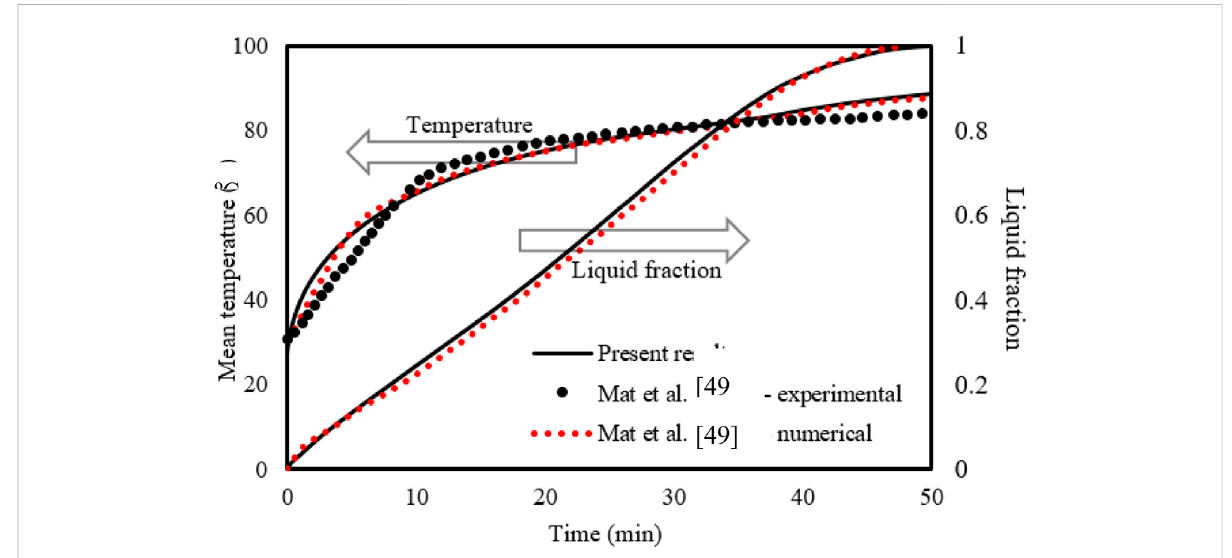
FIGURE 3 Evaluation of the current model ’ s temperature and liquid-fraction results compared to those in the study by Mat et al.